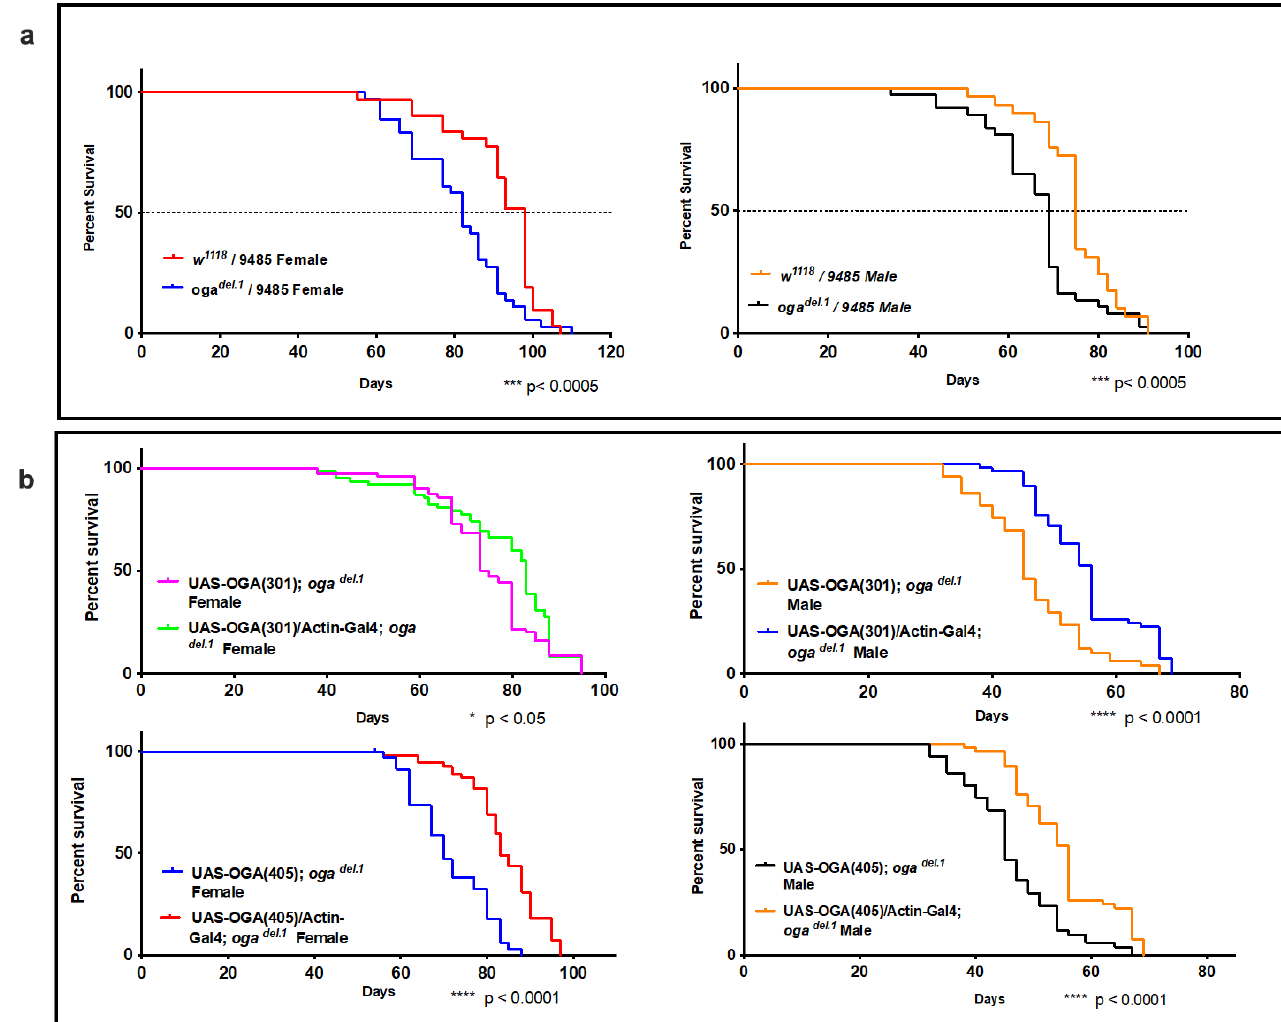
Figure 4. ( a ) oga del.1 mutants have short life spans. Both male and female oga del.1 mutant flies display shorter life spans compared to wild type flies; ( b ) ectopic expression of OGA rescued the short life span of oga del.1 mutants. Statistical comparisons were performed via log-rank test. **** = p < 0.0001, *** p < 0.0005, * p < 0.05.